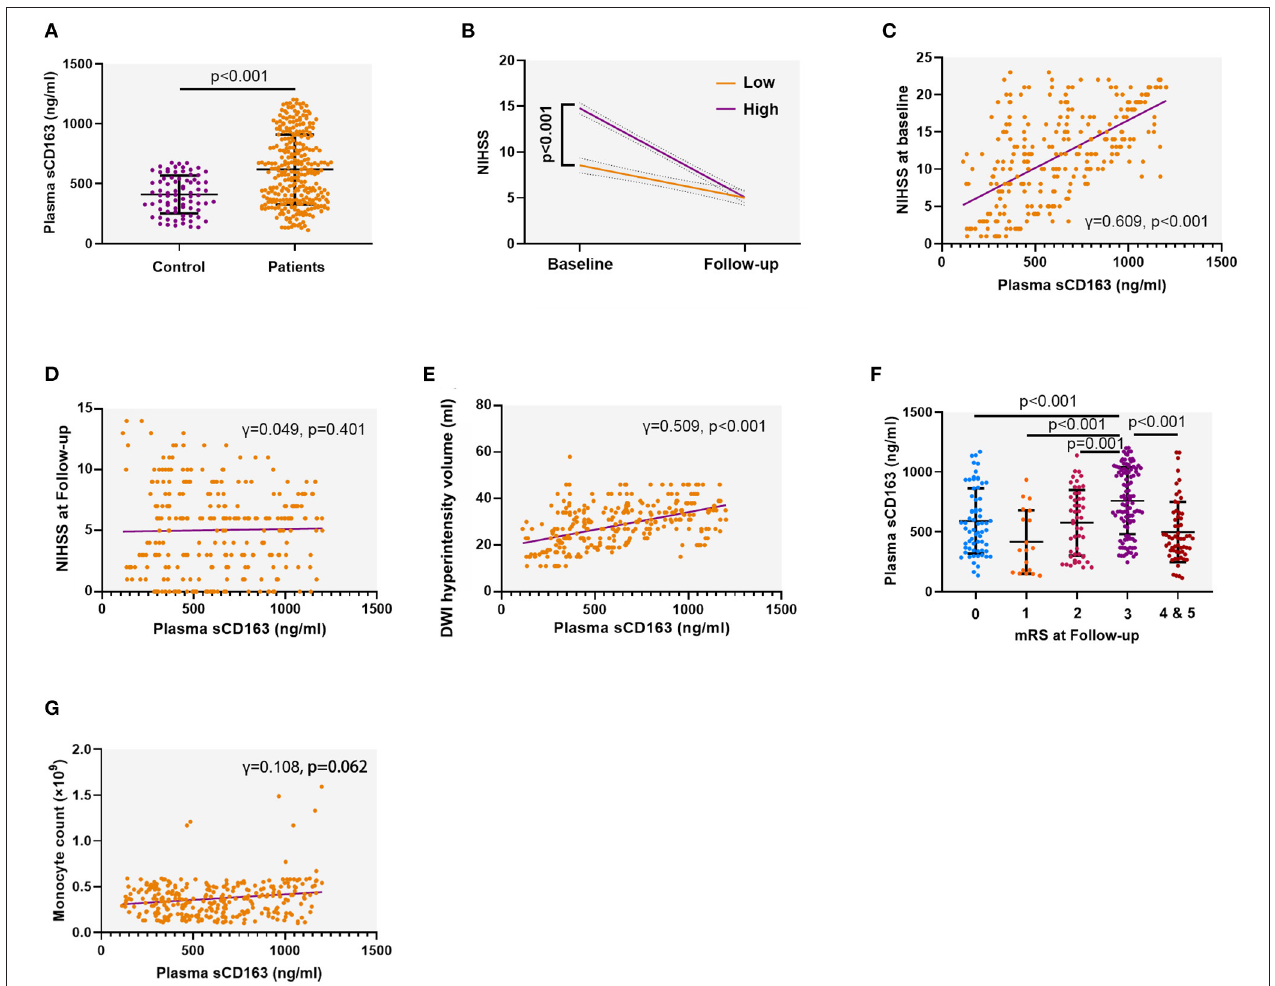
FIGURE 2 | Plasma soluble CD163 (sCD163) is increased in patients with acute ischemic stroke (AIS) and associated with disease severity. (A) Plasma sCD163 concentrations in AIS patients and control. Independent sample t -test. (B) The trajectory of neurological function as indicated by the change of the National Institutes of Health Stroke Scale (NIHSS) during follow-up. Two-way ANOVA. (C) Association between plasma sCD163 concentrations and NIHSS at baseline. Spearman correlation analysis. (D) Association between plasma sCD163 concentrations and NIHSS at follow-up. Spearman correlation analysis. (E,F) Association between plasma sCD163 concentrations and diffusion-weighted imaging (DWI) hyperintensity volume. (G) Association between plasma sCD163 concentrations and circulating monocyte count. DWI, Diffusion-weighted imaging. Spearman correlation